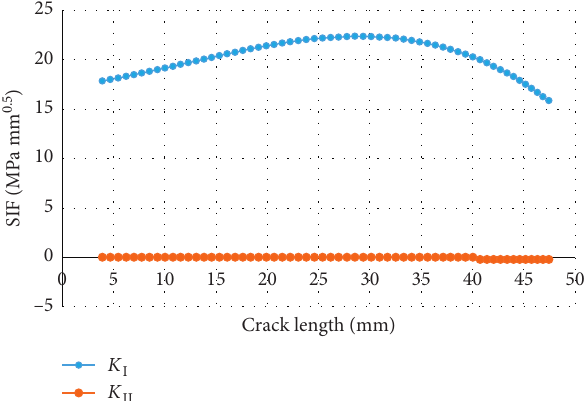
Figure 8: Relationship between SIFs and crack length for crack 3.